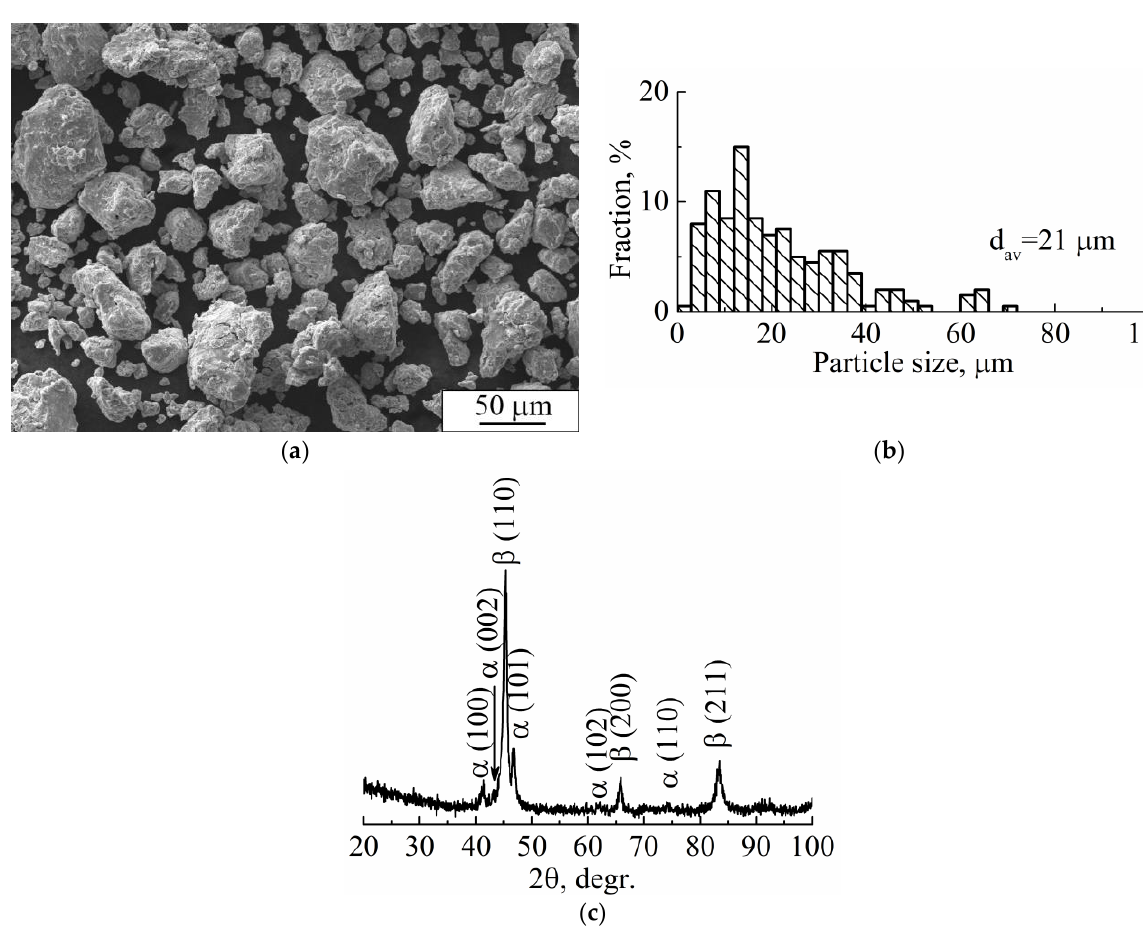
Figure 4. ( a ) SEM image, ( b ) particle size distribution, and ( c ) XRD pattern of mechanically alloyed Ti-Nb powder (d av. is the average particle size).